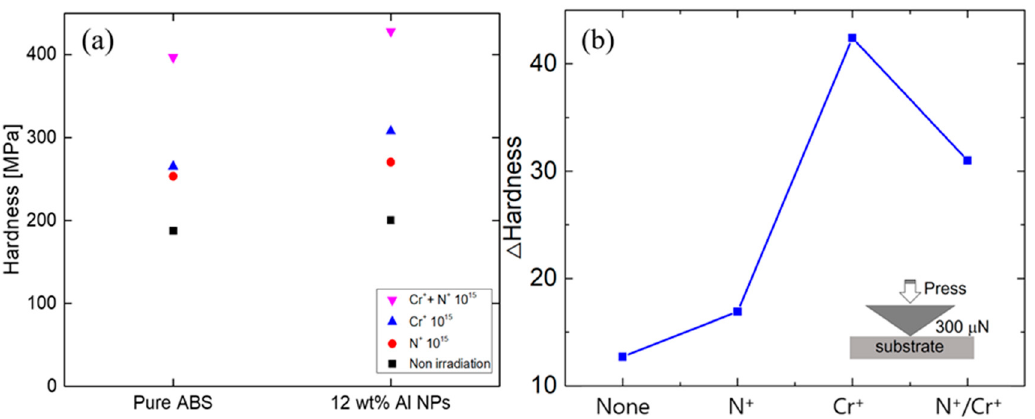
Figure 8. ( a ) Nanoindentation results of nitrogen and chromium ion beams irradiation composite samples and ( b ) difference value of nanoindentation results. ( b ) The inserted figure is a simplified structural image of the nanoindenter.